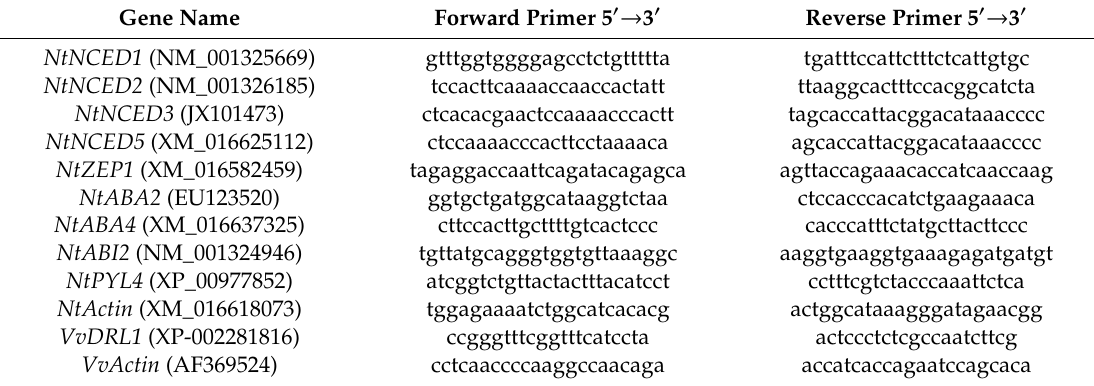
Table 1. Primers in the experiment for